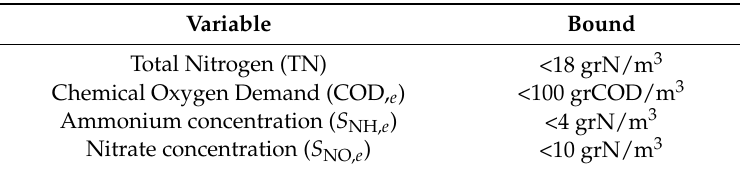
Table 1. Effluent quality